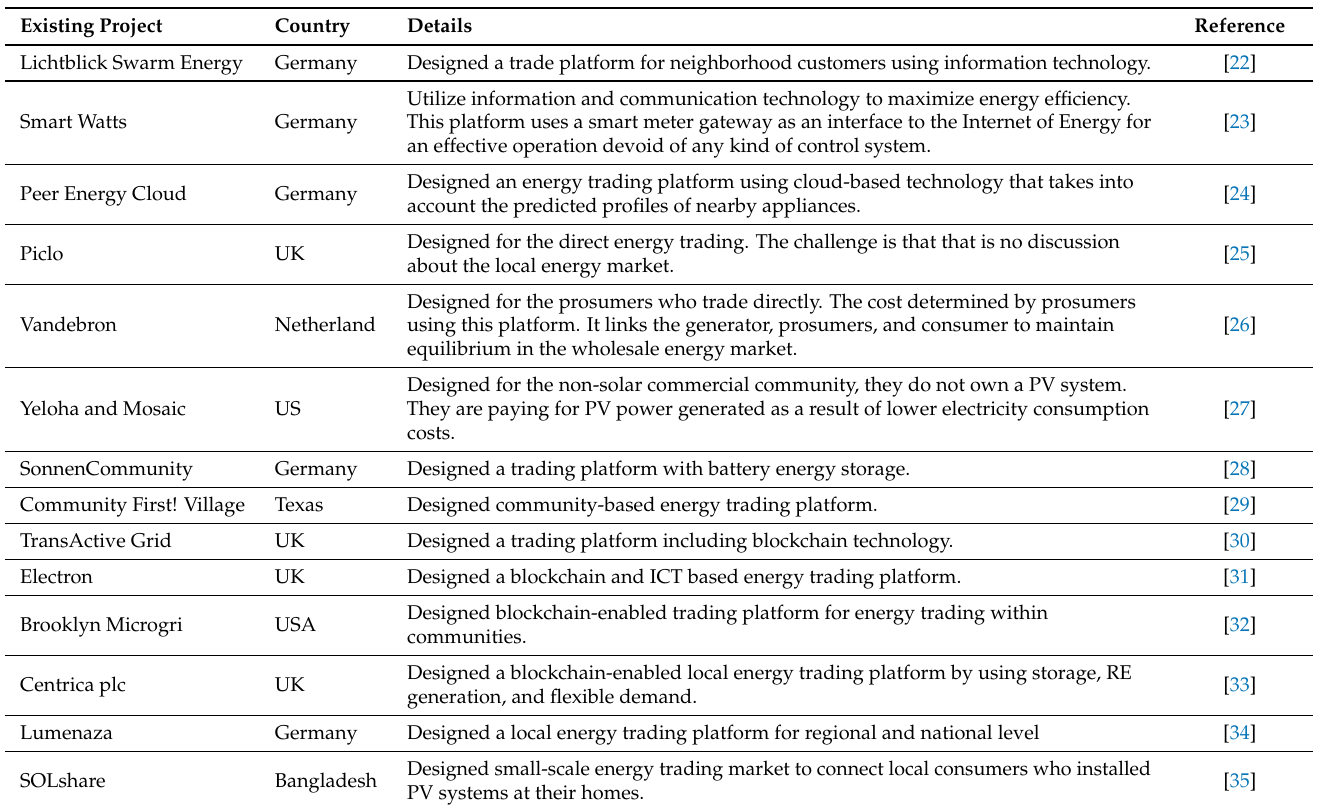
Table 1. Summarize details of existing P2P